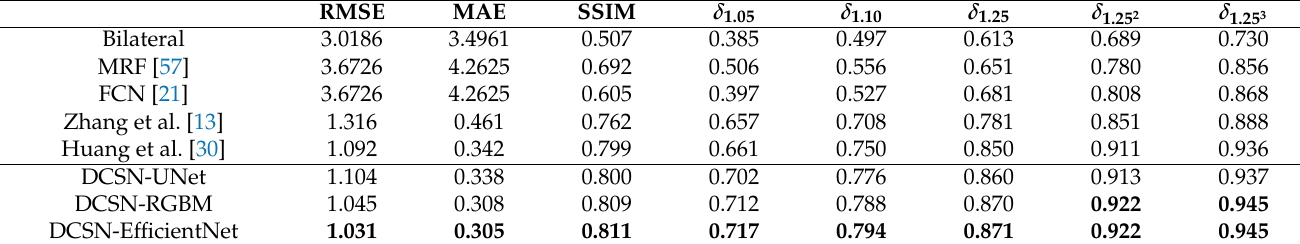
Table 1. The RMSE, MAE, SSIM, and the percentages of pixels within different error ranges for depth completion on the Matterport dataset. The best result is shown in bold. The RMSE of the FCN is from [21], that for the MRF is from [57], and that for the bilateral filter was given in [30]. For the RMSE and MAE, lower is better. For SSIM and the error ranges, higher is